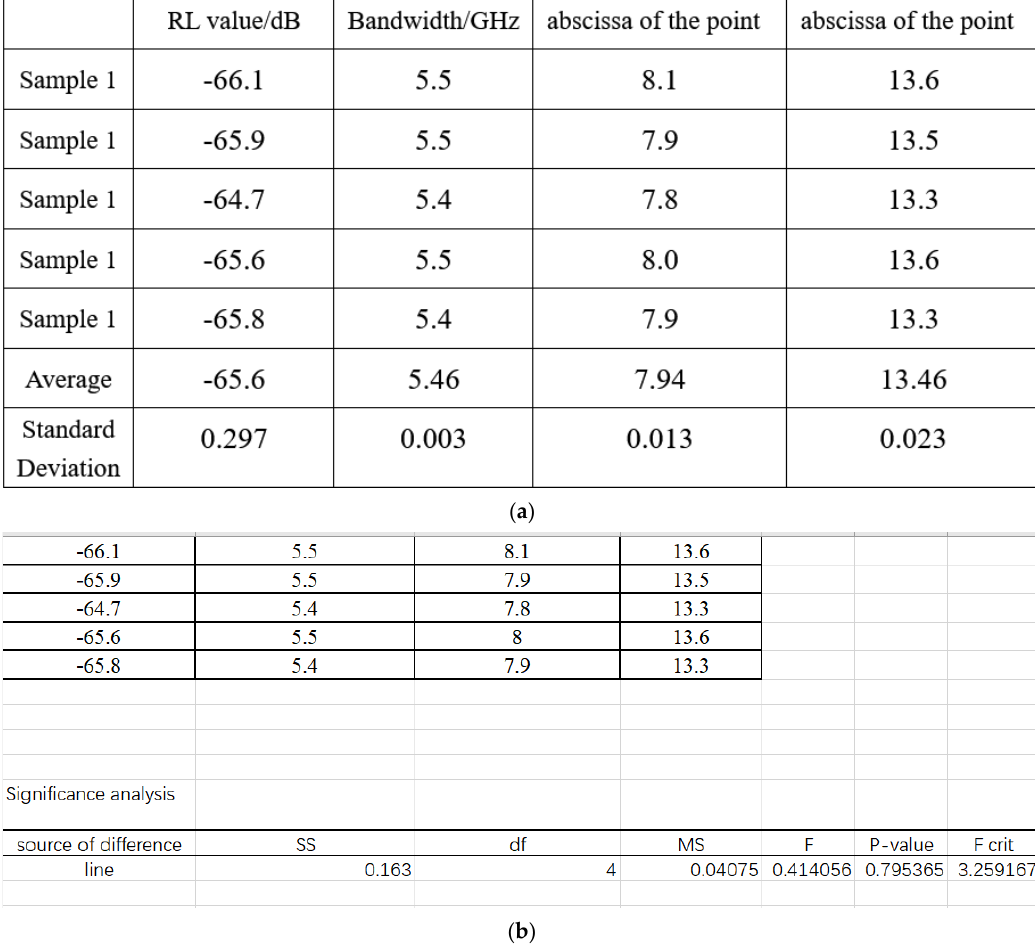
Figure 9. ( a ) the average value and the standard deviation of five samples. ( b ) Significance analysis of five samples.